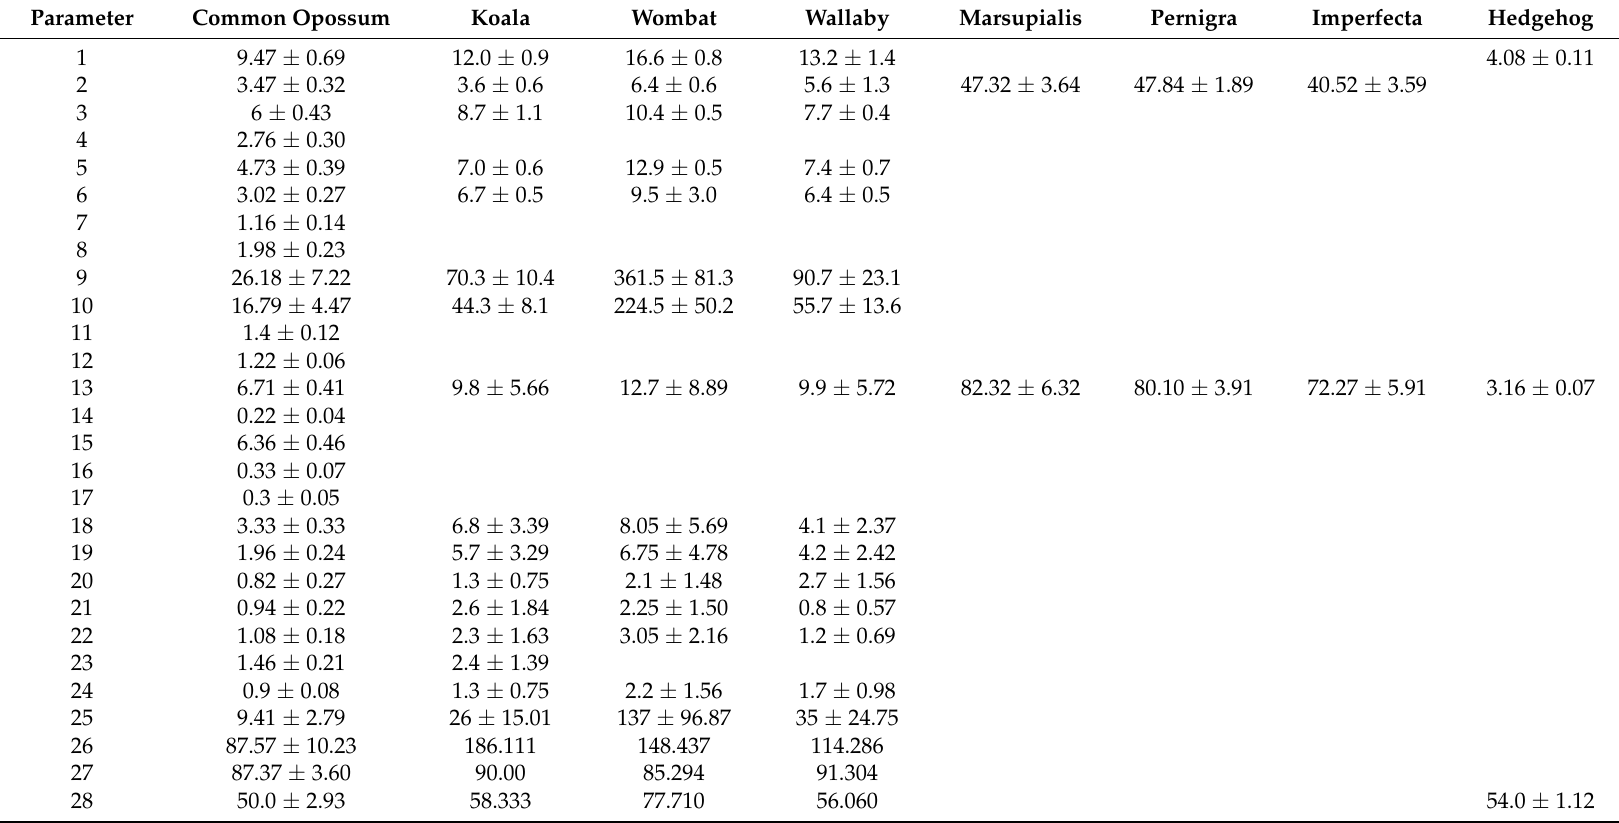
Table 3. Comparison of the morphometry the skull and mandible of the common opossum and other marsupial species. Parameter Common Opossum Koala Wombat Wallaby Pernigra Imperfecta